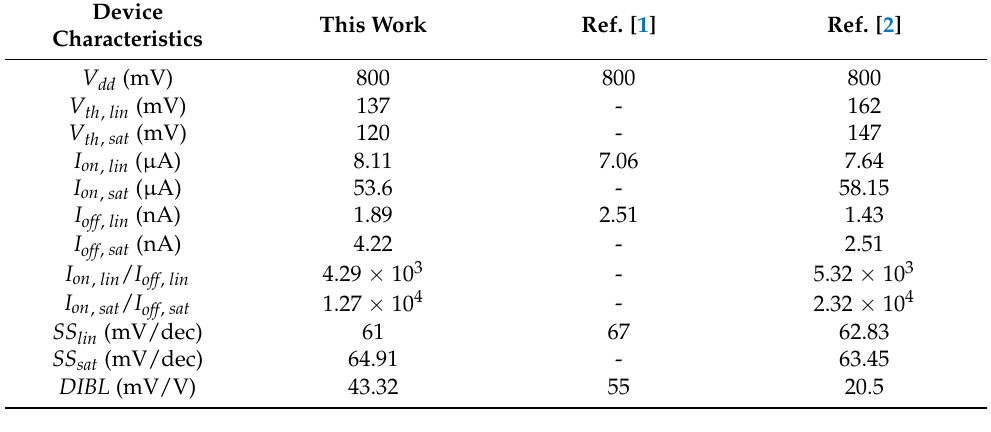
Figure 3. Output I – V curves of the investigated FinFET model with different gate – source voltages. Figure 2. Simulation and experimental I – V curves of the investigated FinFET model [1]. To evaluate the SCEs, the subthreshold slope ( SS ) and drain-induced barrier lower- ing ( DIBL ) are extracted as follows [4,11]